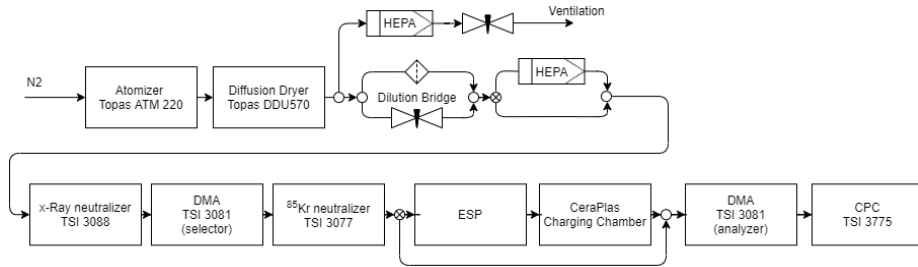
Figure 3. Flow schematics of the experimental setup for the measurement of the charge